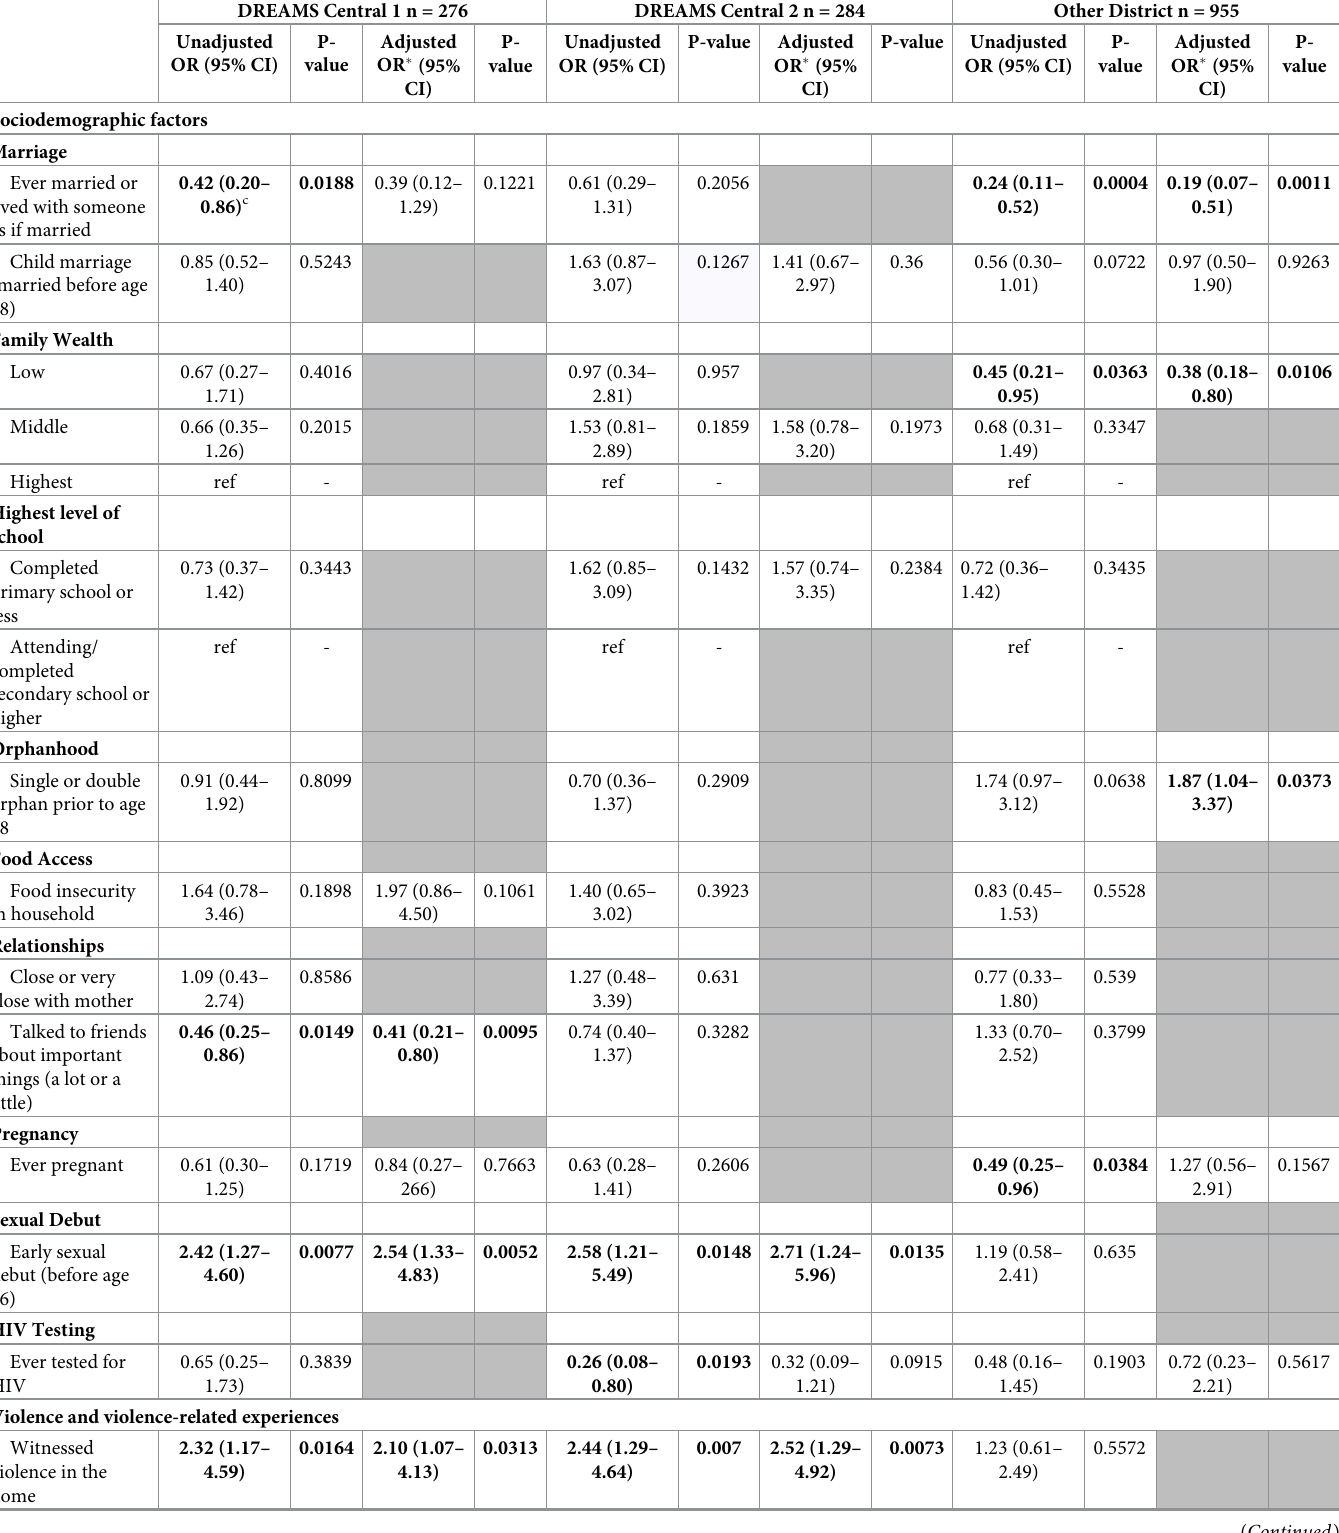
Table 4. Multivariable comparisons between sociodemographic factors, violence, and violence related experiences and recent transactional sex a among sexually acti- ve b Ugandan adolescent girls and young women ages 13–24 years